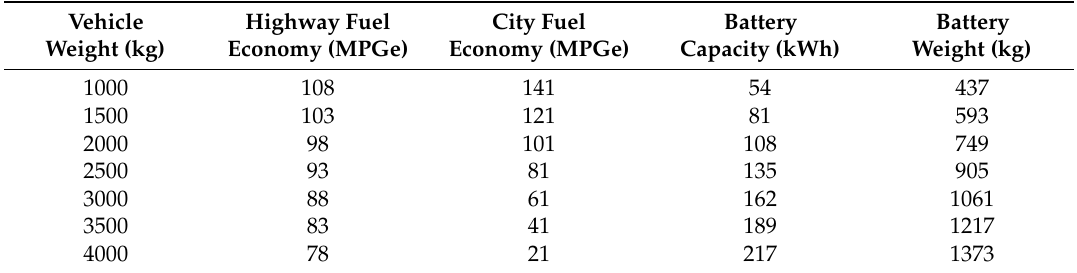
Table 1. Hypothetical calculation to design 400 miles driving range BEV.